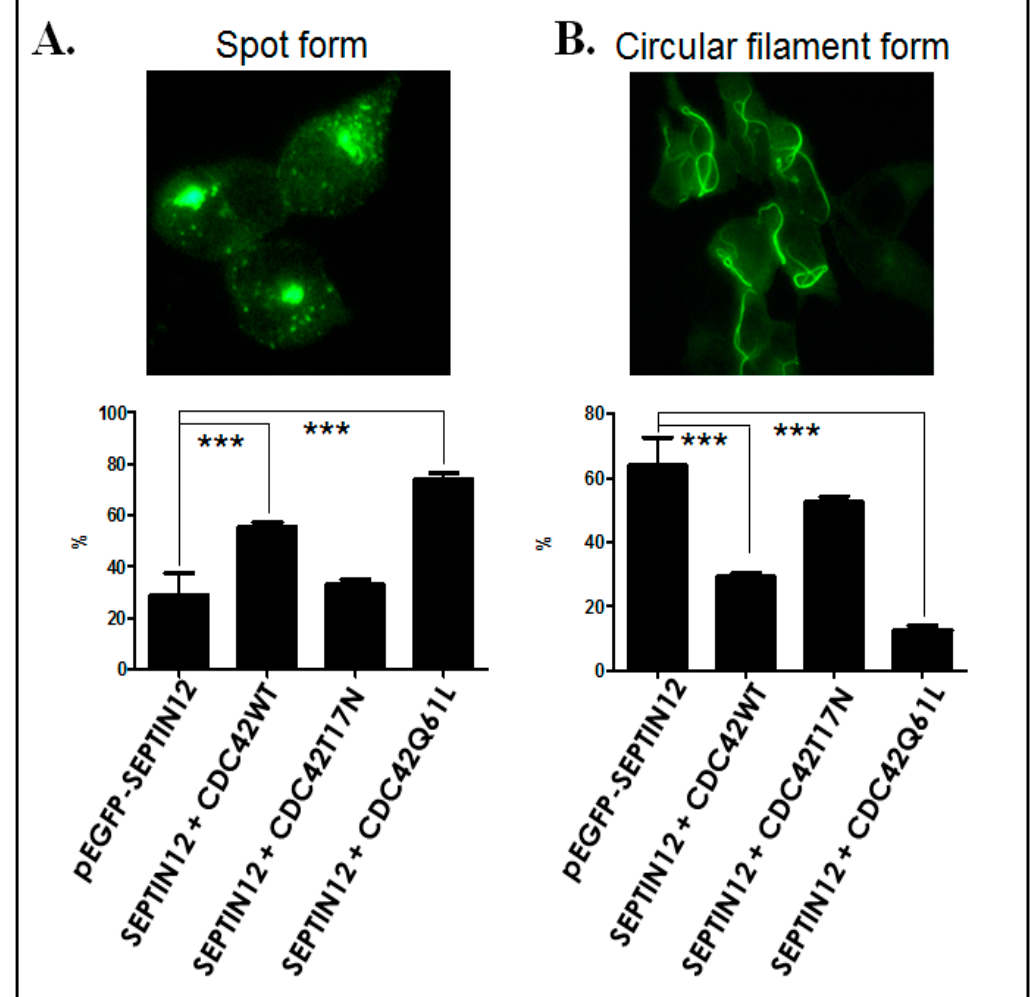
Figure 5. CDC42 overexpression affects SEPT12 polymerization in 293T cells. SEPT12 overexpression leads to a spot form ( A , upper panel) or a circular filament form ( B , bottom panel). Magnification: ×400 in ( A , B ). ( A , B ; bottom panel) Quantification of the percentage of spot and circular filament forms in the transfected cells. The height of the boxes represents the mean of the values obtained from four independent experiments. At least 100 transfected cells were counted in each experiment (*** p < 0.001, Student’s t test).